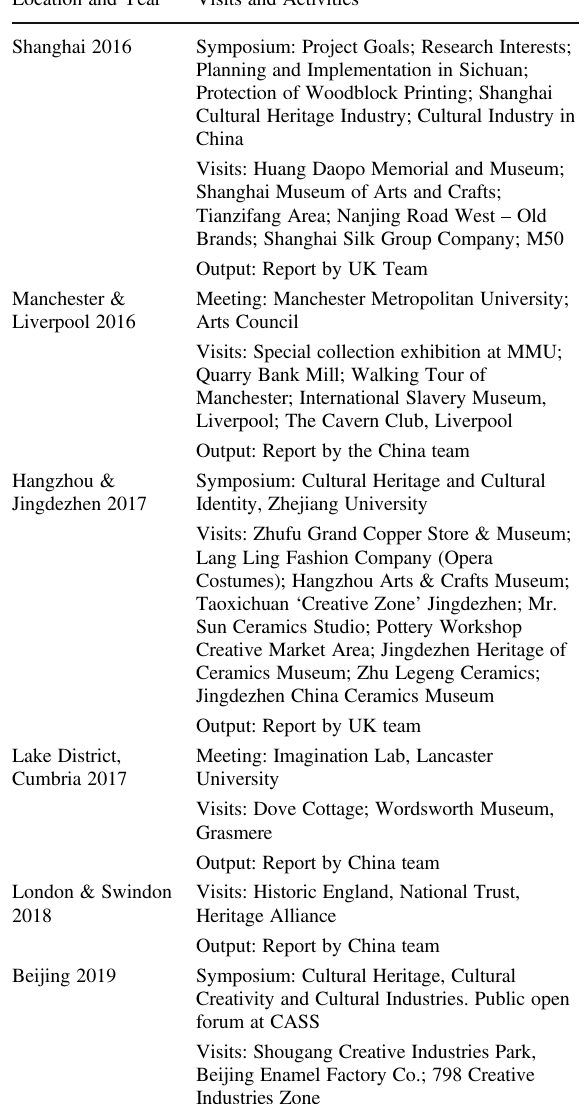
Table 1 Design Ecologies Knowledge Exchange